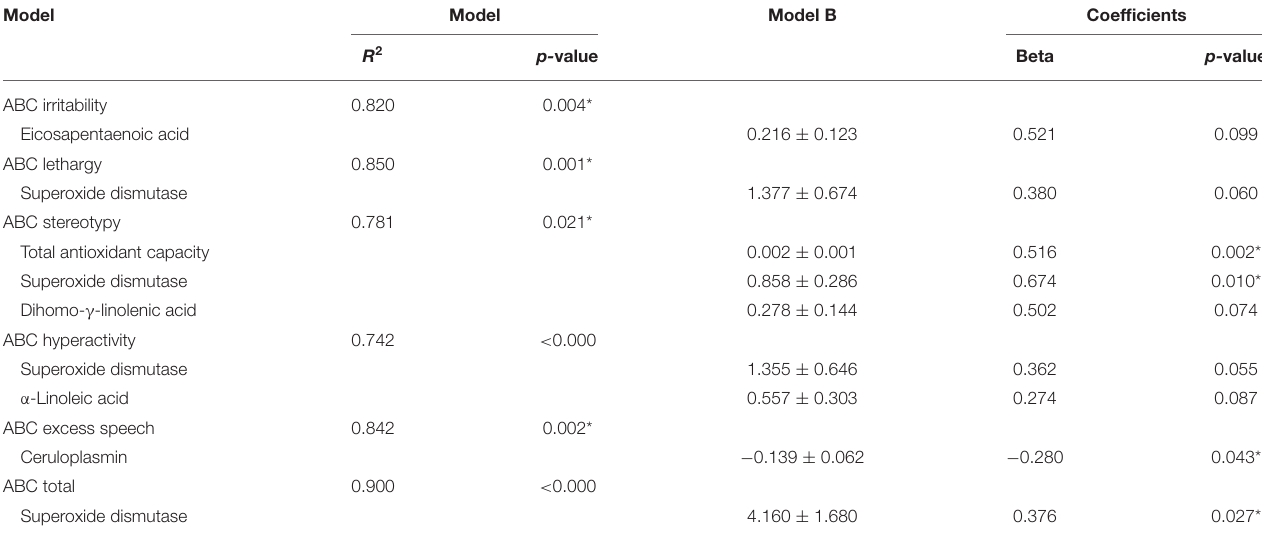
TABLE 2 | Results of libear regressuin